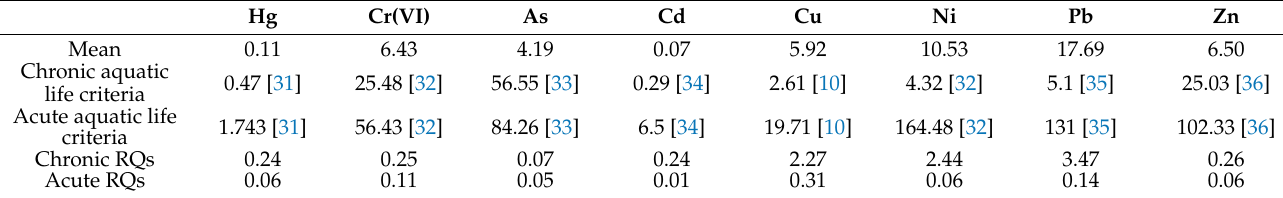
Table 5. Risk quotients (RQs) of heavy metals in the surface water of Taihu Lake.